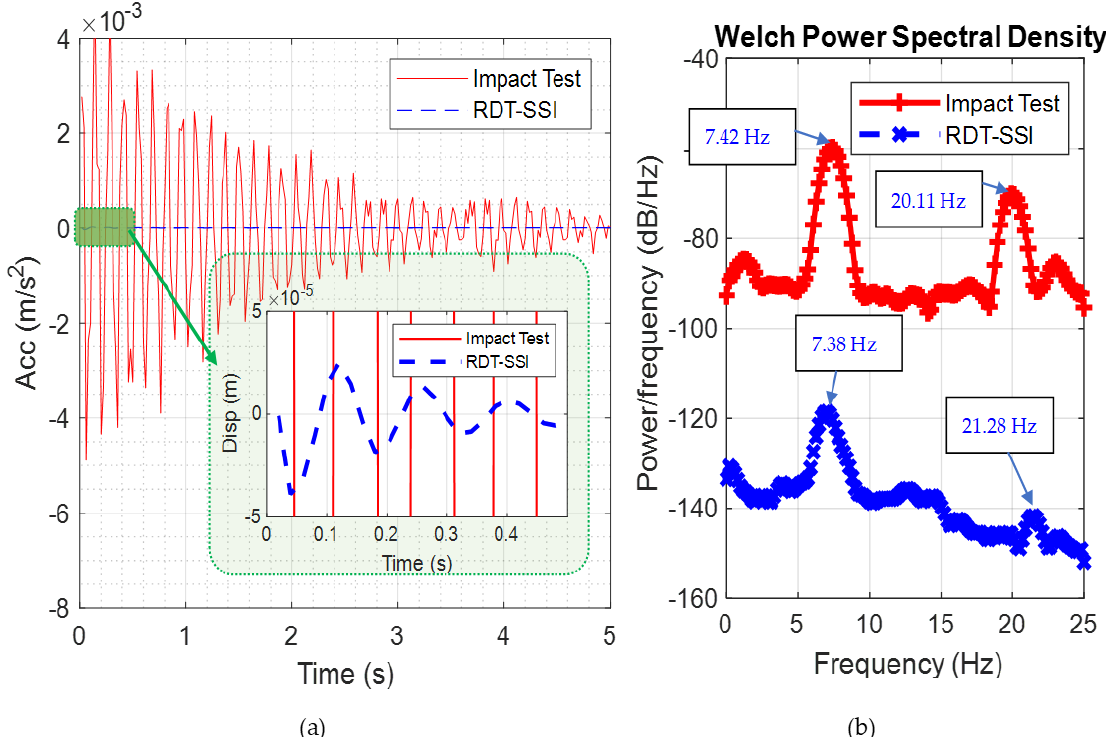
Figure 5. Experimental setup.